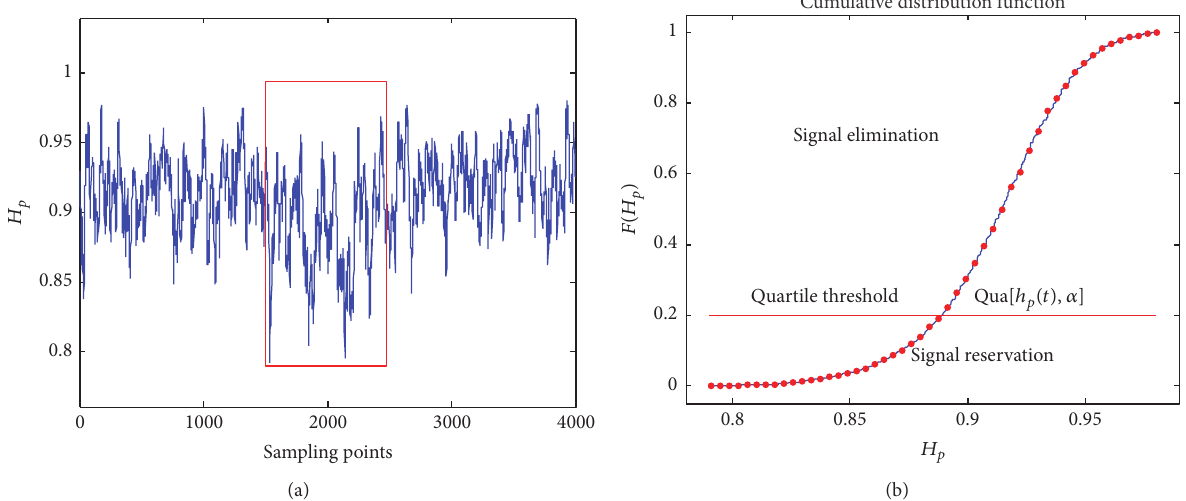
Figure 6: The principle of signal selection based on PE. (a) Variation curves of PE values of the simulation signals; (b) the cumulative distribution function of PE